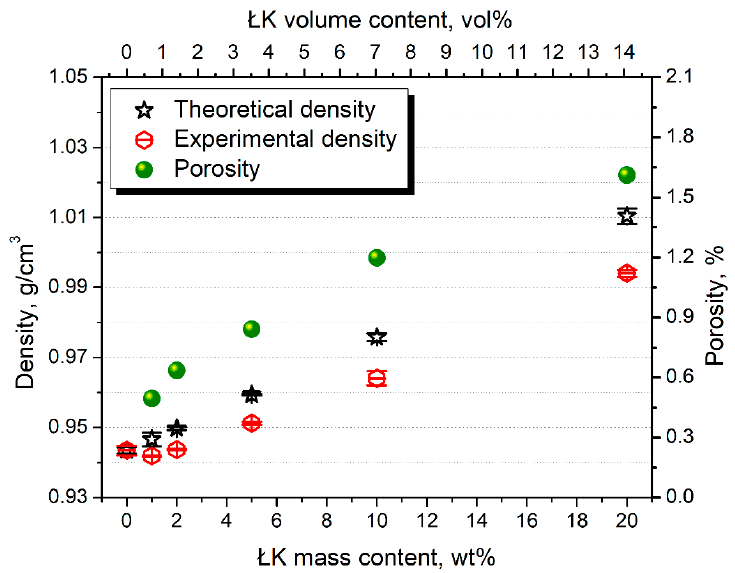
Figure 3. The theoretical and experimental density of composites and calculated porosity